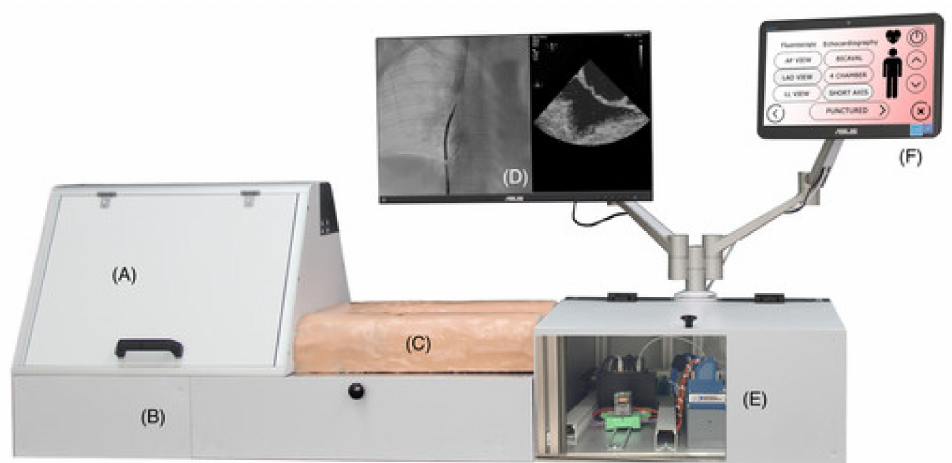
Figure 13. Multi-system cardiac catheterization simulator ( A ) space for silicone rubber for fluoroscopy emulation; ( B ) space for stereo camera for transesophageal echocardiography; ( C ) Catherization pad; ( D ) screen displaying fluoroscopy imaging; ( E ) electronics compartment; and ( F ) touch pad for the graphical user interface of the system [24].